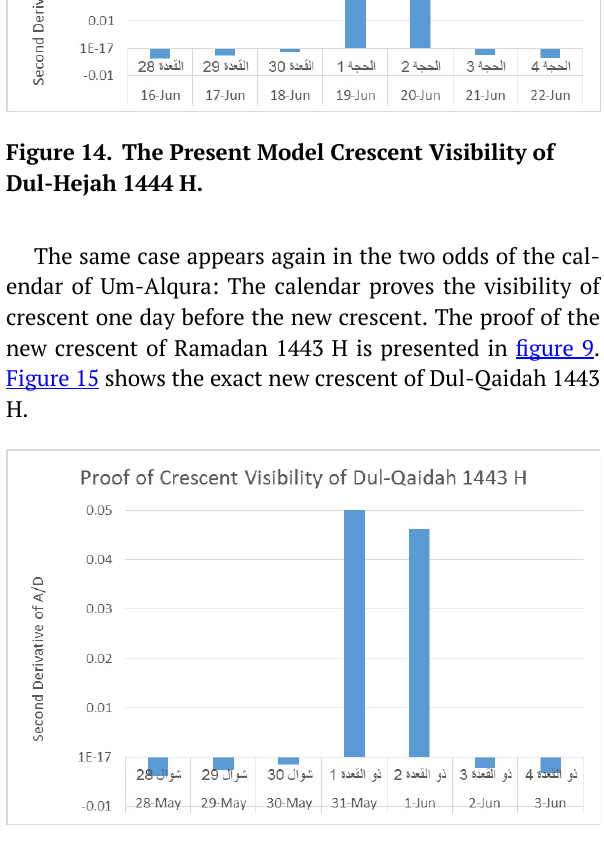
Figure 15. The Present Model Crescent Visibility of Dul-Qaidah 1443 H.